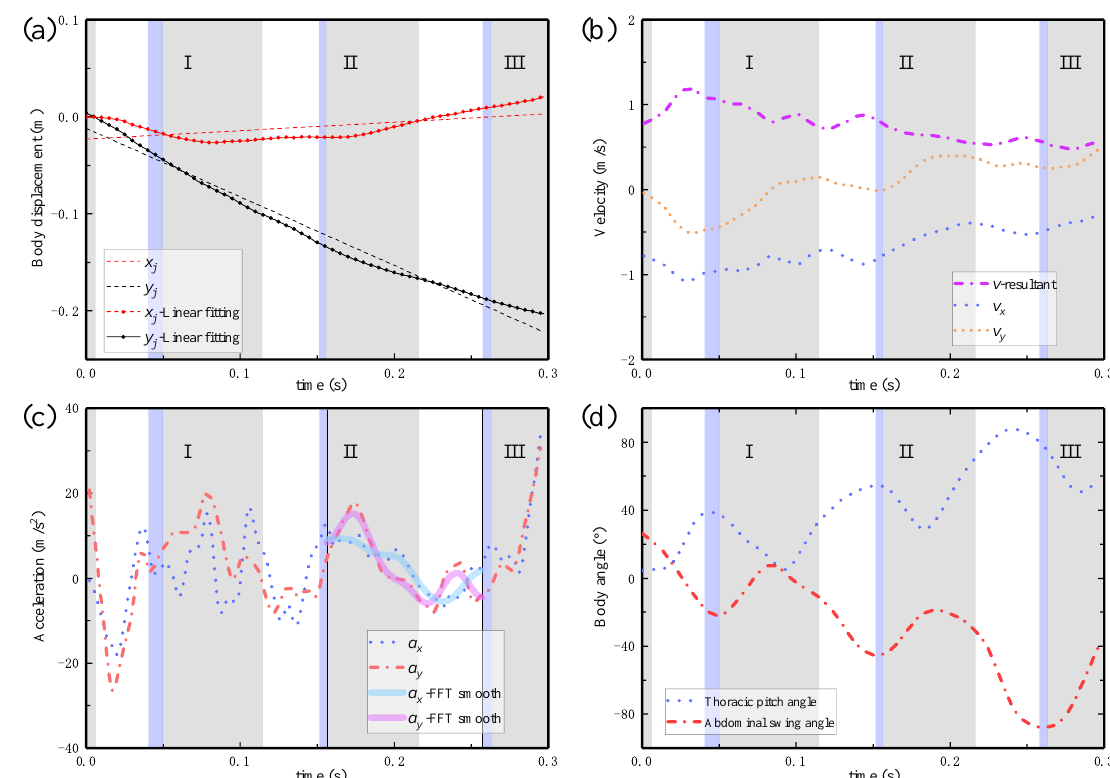
Figure 6. Time variations of body kinematics of VC2: ( a ) displacement of the joint point during forward flight; ( b ) velocity of the butterfly centroid (joint point); ( c ) acceleration of the butterfly centroid and FFT smoothing for the second flapping cycle; and ( d ) oscillation of thoracic pitch angle ( θ p ) and abdominal swing angle ( θ a ) . Grey shading indicates the DS, purple shading denotes the gliding moment, and white shading denotes the US.